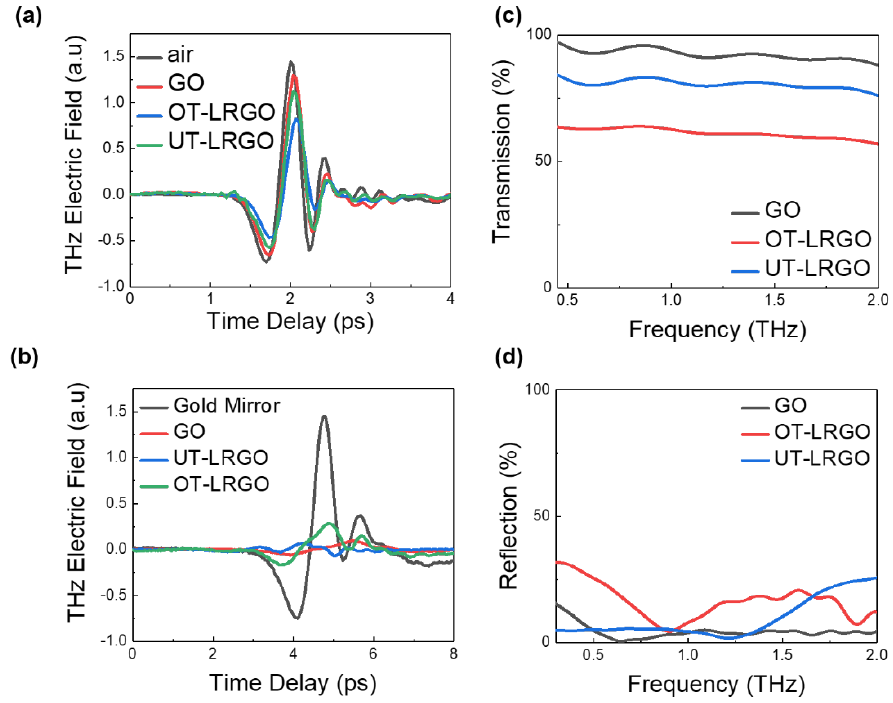
Figure 2. ( a ) Transmitted THz signals in the time domain of the air, GO, OT-LRGO, and UT-LRGO. ( b ) Reflected THz signals in the time domain of the Au, GO, and OT-LRGO (optimal treatment LRGO:15 times fabrication LRGO with scanning speed is 750 mm/s); UT-LRGO (5 times fabrication LRGO with scanning speed is 750 mm/s). ( c ) Transmission spectra of the GO, UT-LRGO, and OT-LRGO. ( d ) Reflection spectra of the GO, UT-LRGO, and OT-LRGO.